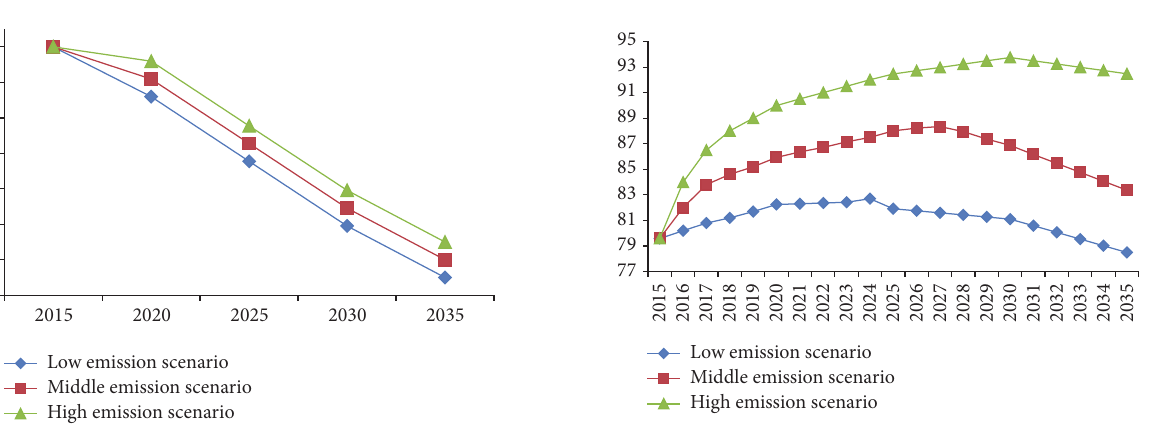
Figure 12: The trends of energy consumption structure in the low, middle, and high emission scenarios (%).